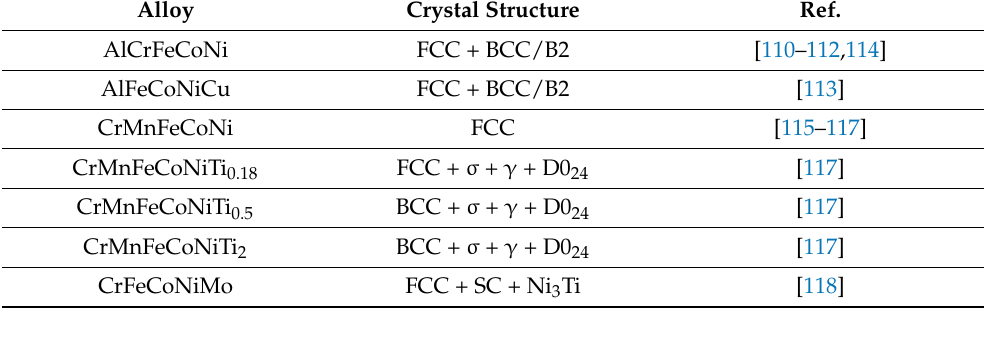
Table 3. HEAs fabricated by EB-PBF process using pre-alloyed powders as feedstock material. Alloy Crystal Structure